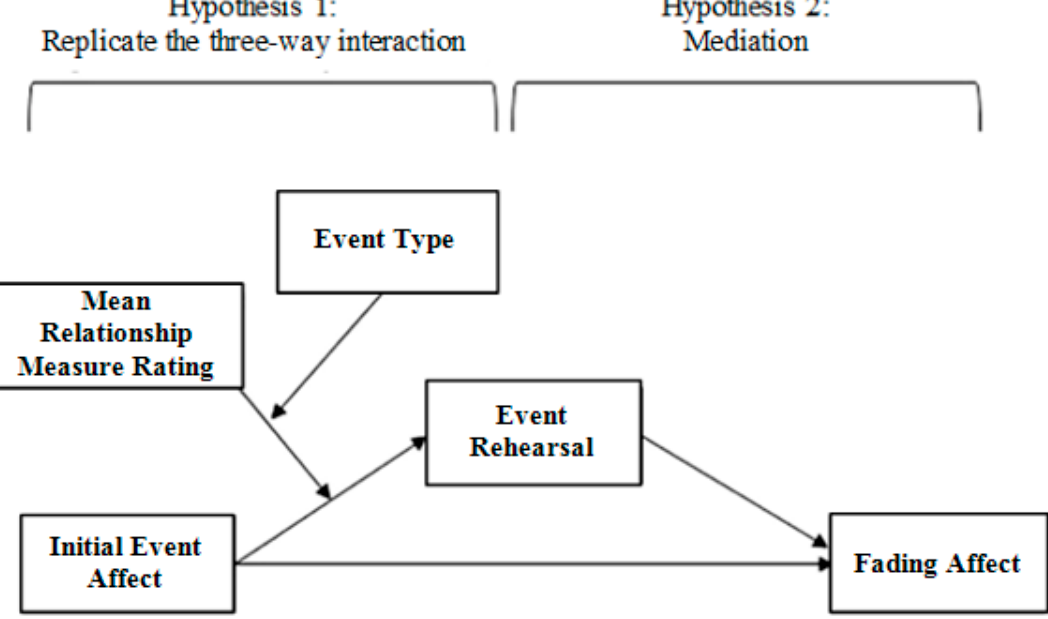
Figure 1. The three-way interaction between initial event affect, event type, and a relationship variable (e.g., relationship satisfaction) predicts fading affect through the mediatior of event rehearsal frequency.